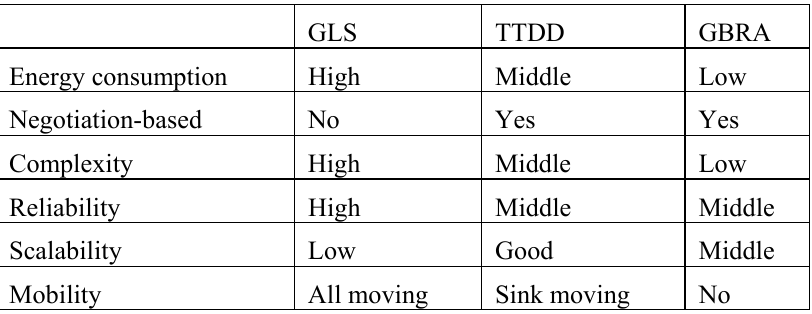
Table 2. Comparison among GLS, TTDD and GBRA.